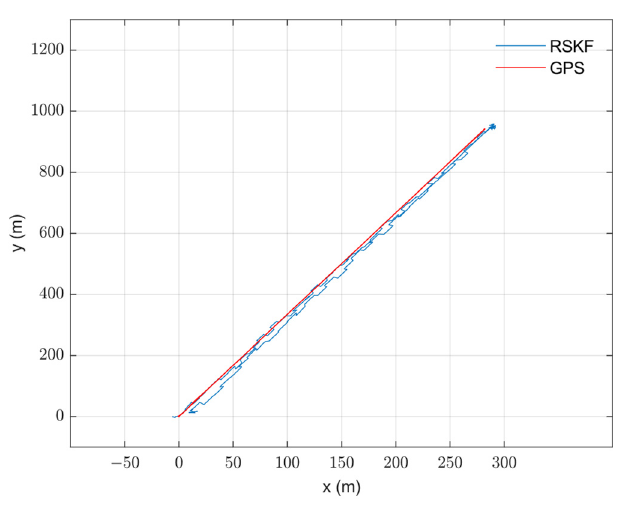
Figure 7. The calculated integrated navigation 3D path using RSKF with the reference 3D path.